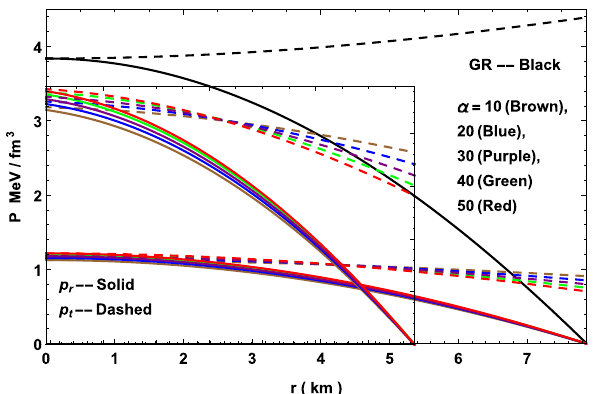
Fig. 2 Variation of density for 4U 1538-52 using the parameter pro- vided in Table 1